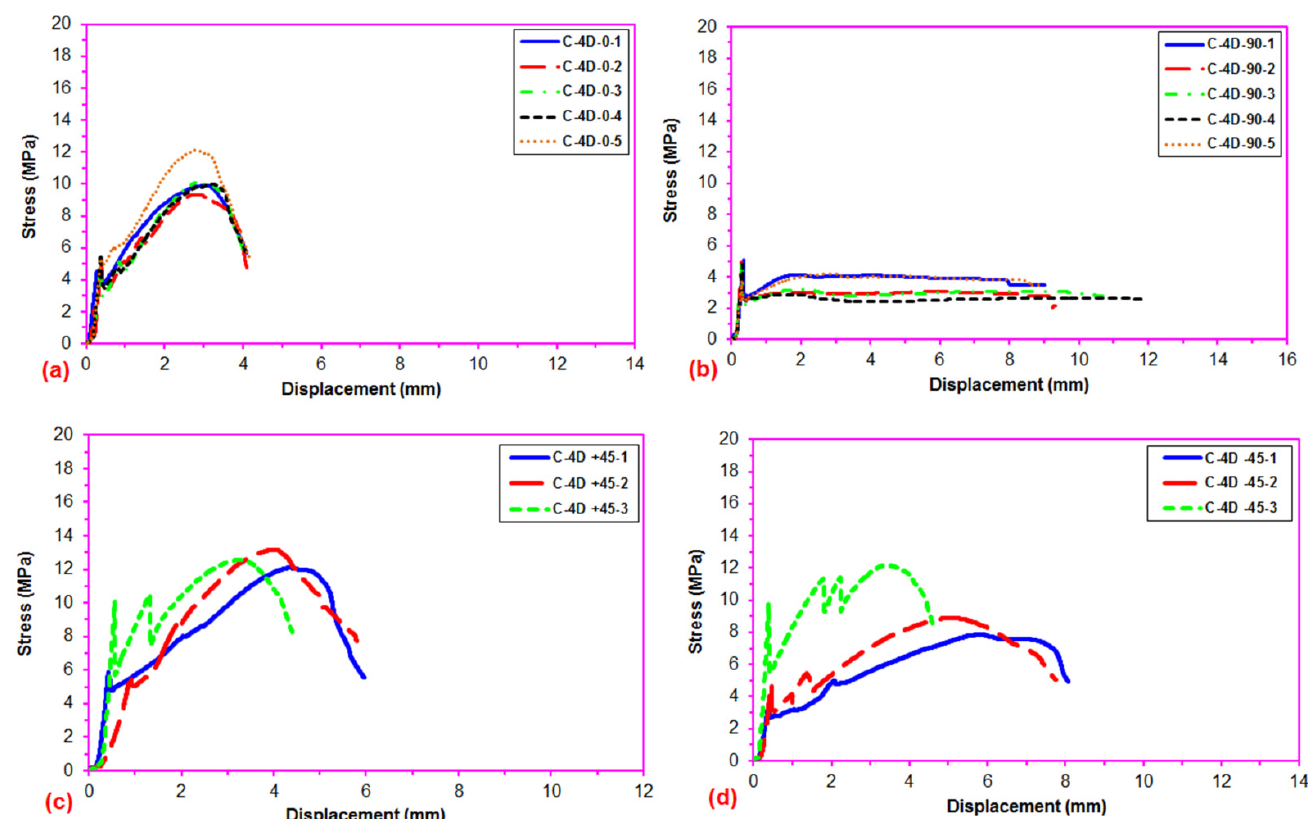
Figure 8. Stress-displacement curves of multiaxis 3D carbon fiber concretes. ( a ) C-4D at 0 degree flexural test; ( b ) C-4D at 90 degree flexural test; ( c ) C-4D at +45 direction flexural test; ( d ) C-4D at − 45 direction flexural test.